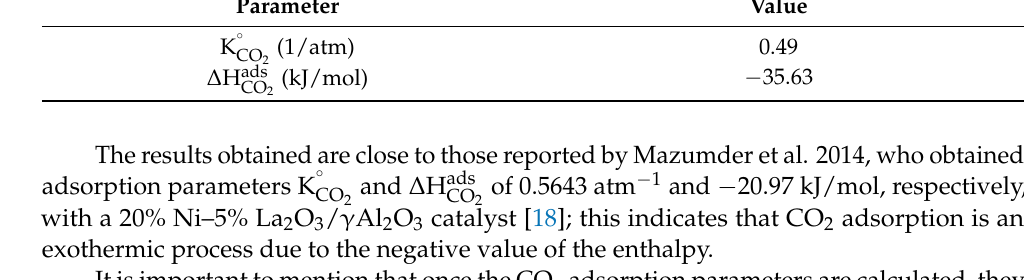
Table 6. CO 2 adsorption parameters with the catalyst 5% Ni–0.25% Ru/ γ Al 2 O 3 . Parameter